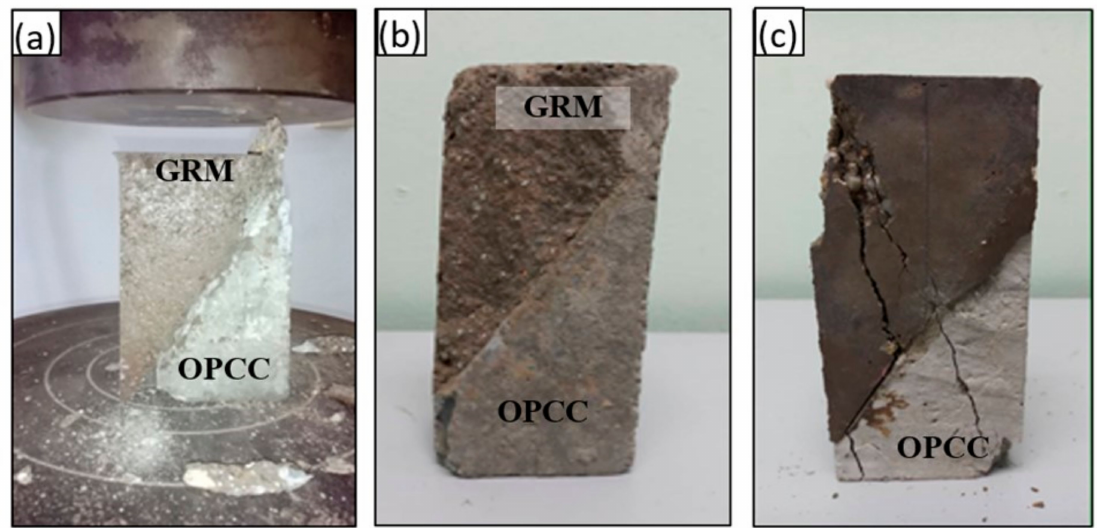
Figure 9. Mode of failure: ( a ) interface failure (Type A); ( b ) substratum failure with good interface (Type B); and ( c ) interface failure and substrate fracture (Type